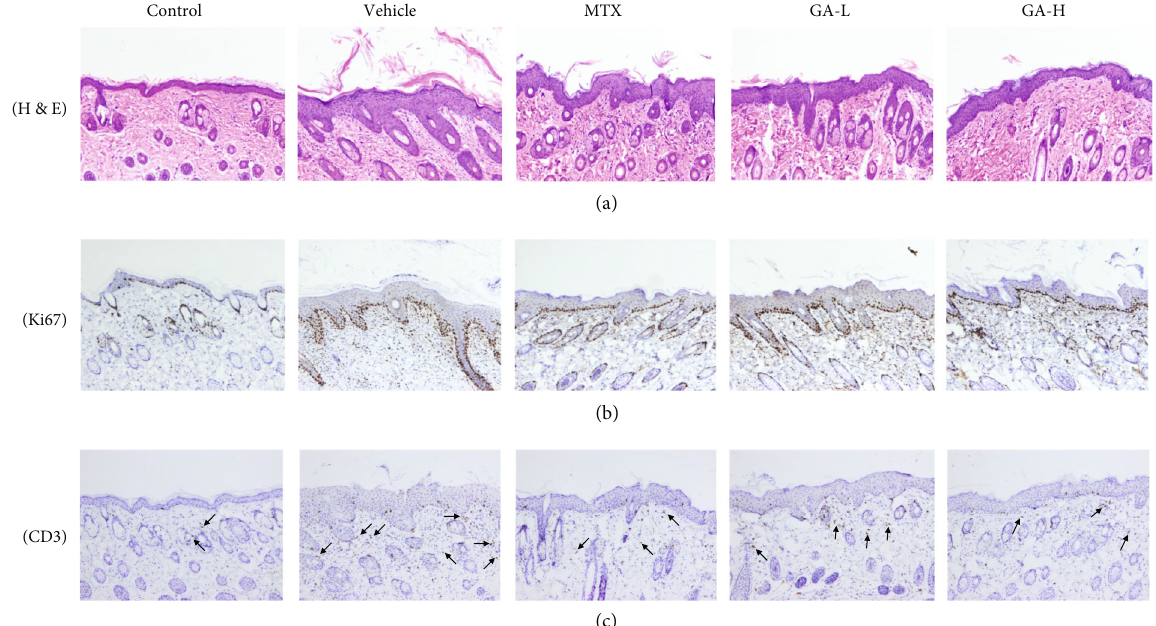
Figure 3: Histological analysis and immunohistochemistry assay. Di ff erent treatments (MTX and GA) were applied to the mice for 7 days. H&E staining of the dorsal skin lesion (a) in di ff erent treatment groups. Immunohistochemical images of Ki67 (b) or CD3 (c) staining (magni fi cation: 100x) of dorsal skin in control or psoriatic mice 7 days after